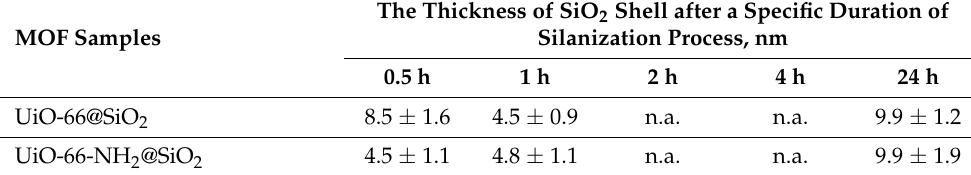
Table 1. Shell thickness in UiO-66@SiO 2 and UiO-66-NH 2 @SiO 2 MOFs depending on the duration of incubation in TEOS. n.a.—not available.